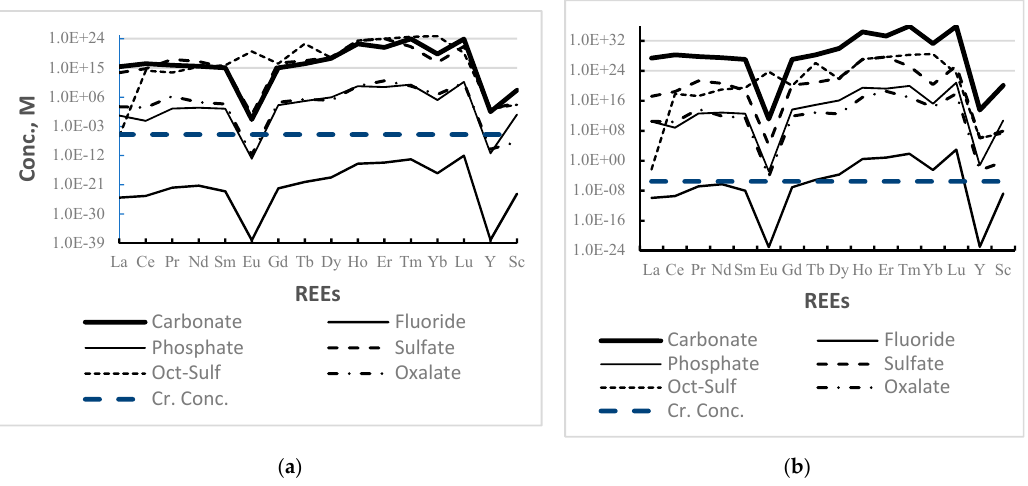
Figure 8. Concentration of ReCl 2+ in equilibrium with various precipitants at 10 − 4 M and at ( a ) pH 4 and ( b ) pH 1.